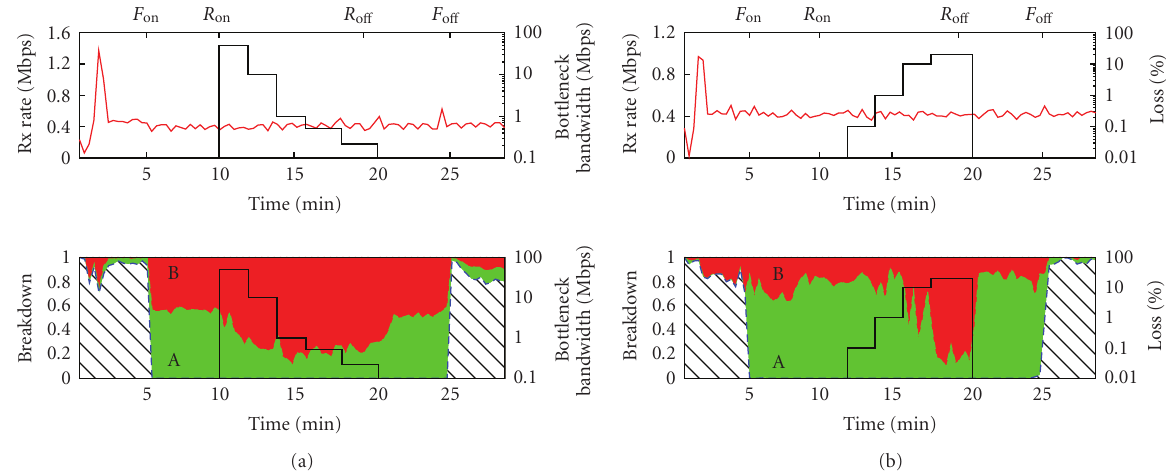
Figure 2: Pathwise metrics: PPLive aggregated received rate at P (top) and its breakdown between A, B and Internet hosts (bottom) for varying bottleneck bandwidth (a) and packet loss (b). Profiles of the bottleneck bandwidth and packet loss impairments are reported as solid black lines directly in the plot and refer to the right y -axis. PPLive shows a great sensitivity towards path capacity variations while it reacts only to very high loss